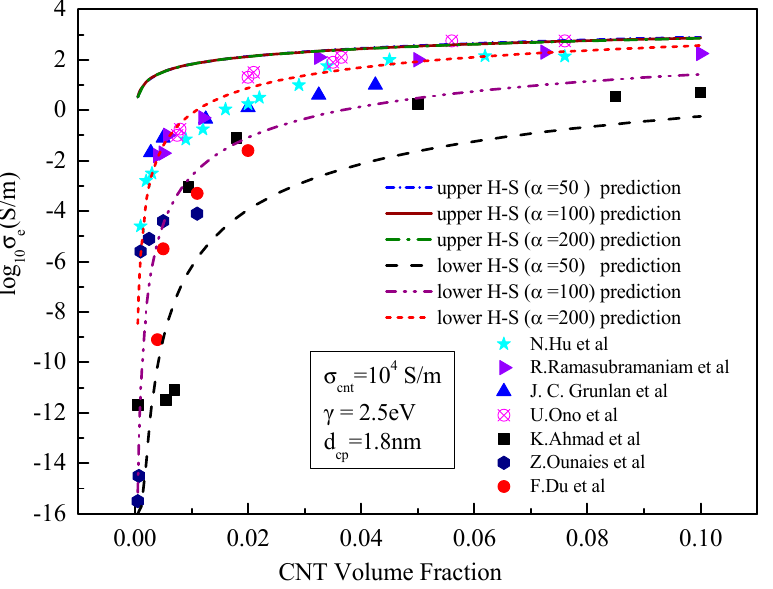
Figure 7. Comparison between the prediction results of the upper- and lower-bound models and existing experimental data [21,23–28] with the variable CNT aspect ratio.